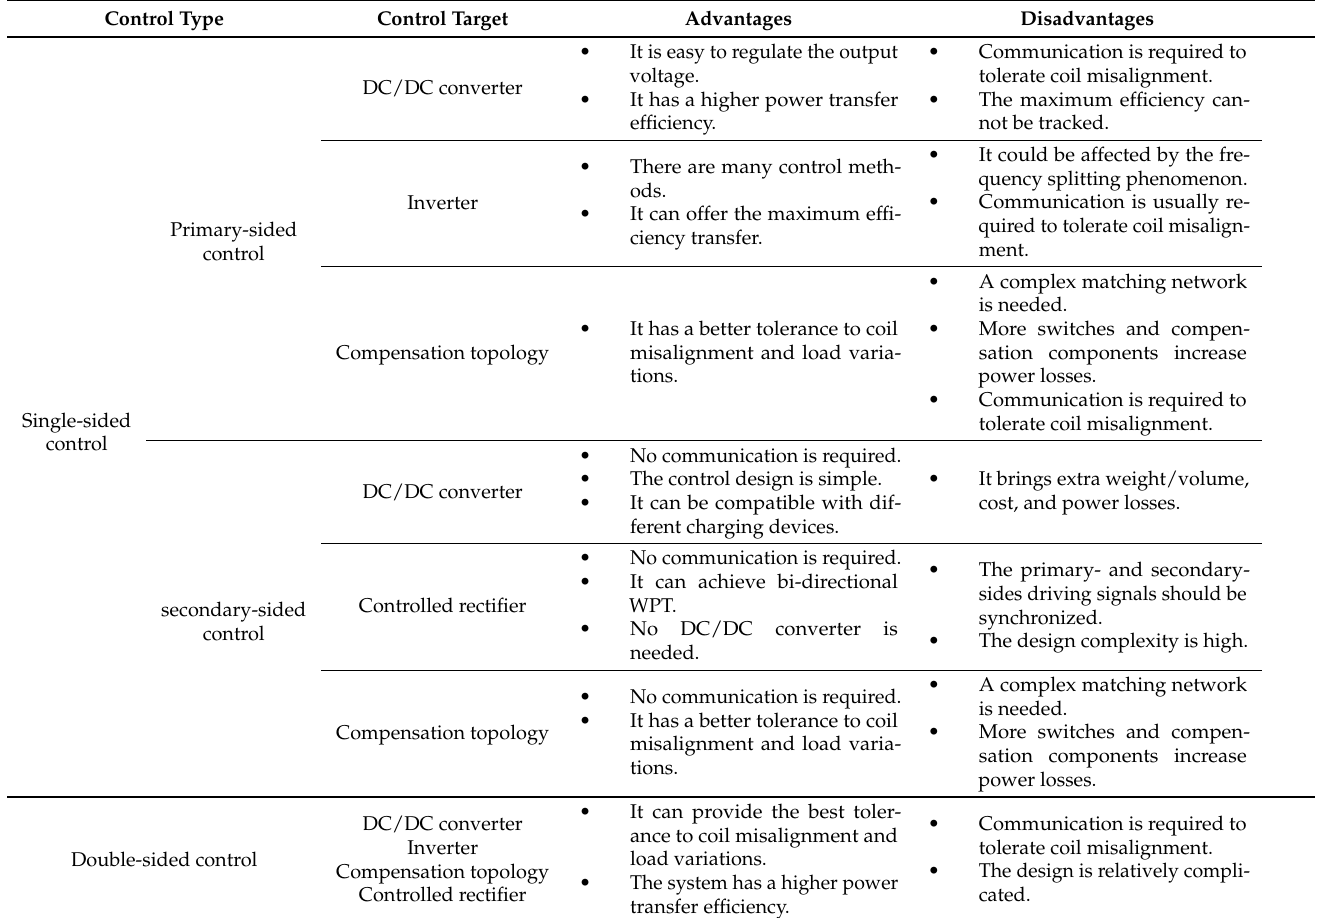
Table 7. Summary and comparison of the control